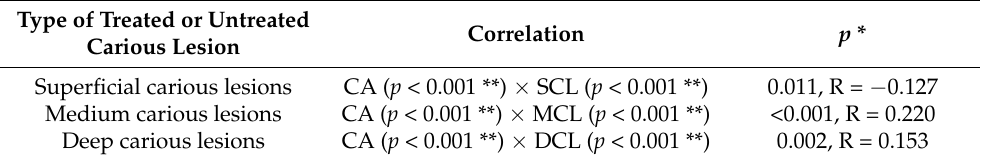
Table 3. Correlations between chronological age and superficial, medium, and deep carious